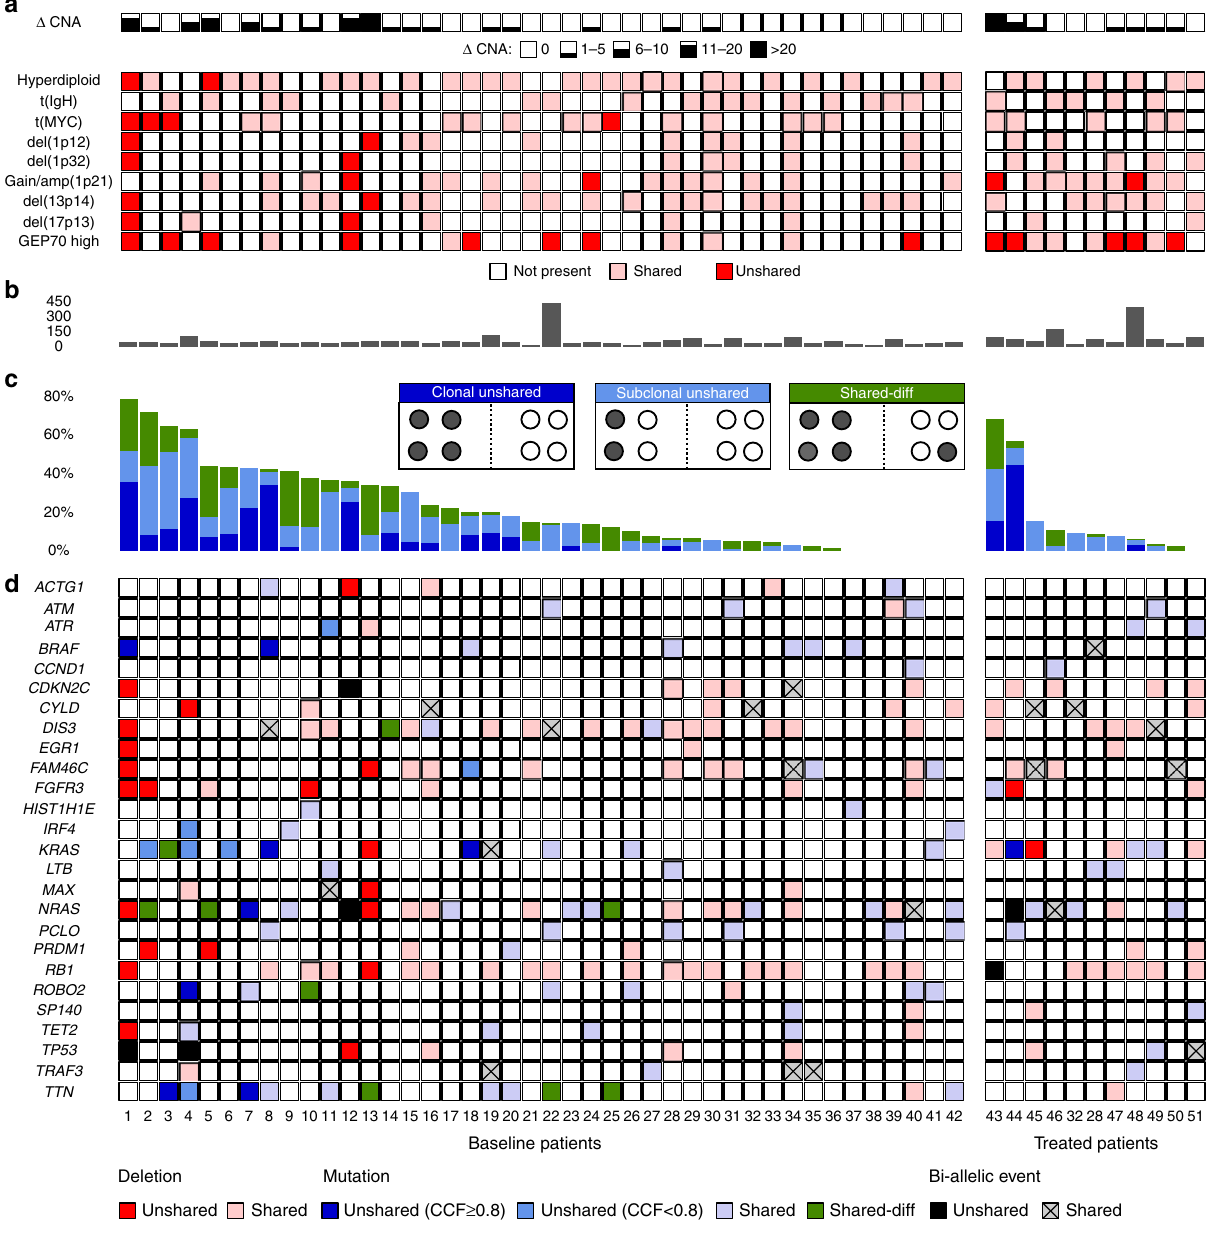
Fig. 2 Spatial heterogeneity in baseline and treated patients. In the upper panel of a the number of unshared copy number aberrations between paired iliac crest and fi ne needle aspirates ( Δ CNA, > 1 Mb) is shown. In the lower panel of a heterogeneity involving the initiating events hyperdiploidy and recurrent IgH translocations as well as commonly used prognostic markers is presented with light and dark red indicating shared and unshared events, respectively. The total number of non-silent mutations is presented in b . c Proportion of clonal unshared (cancer clonal fraction (CCF ) ≥ 0.8; dark blue ), subclonal unshared ( CCF < 0.8; corn fl ower blue ) and shared-diff ( green ) non-silent mutations. In d , non-silent mutations and deletions affecting the most frequently mutated genes in our set and other recurrently mutated genes in multiple myeloma are shown. Dark blue and corn fl ower blue denote clonal and subclonal unshared mutations, green shared-diff mutations, red deletions and black bi-allelic events. Light colors or crossed boxes indicate shared